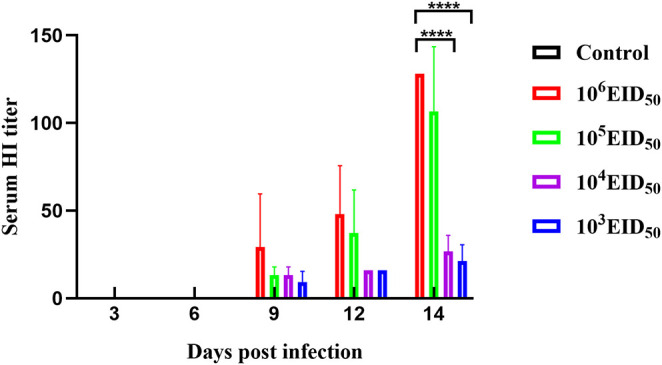
A HI titer was conducted to evaluate the sera specific antibody levels. Error bars represent the standard errors of the mean.